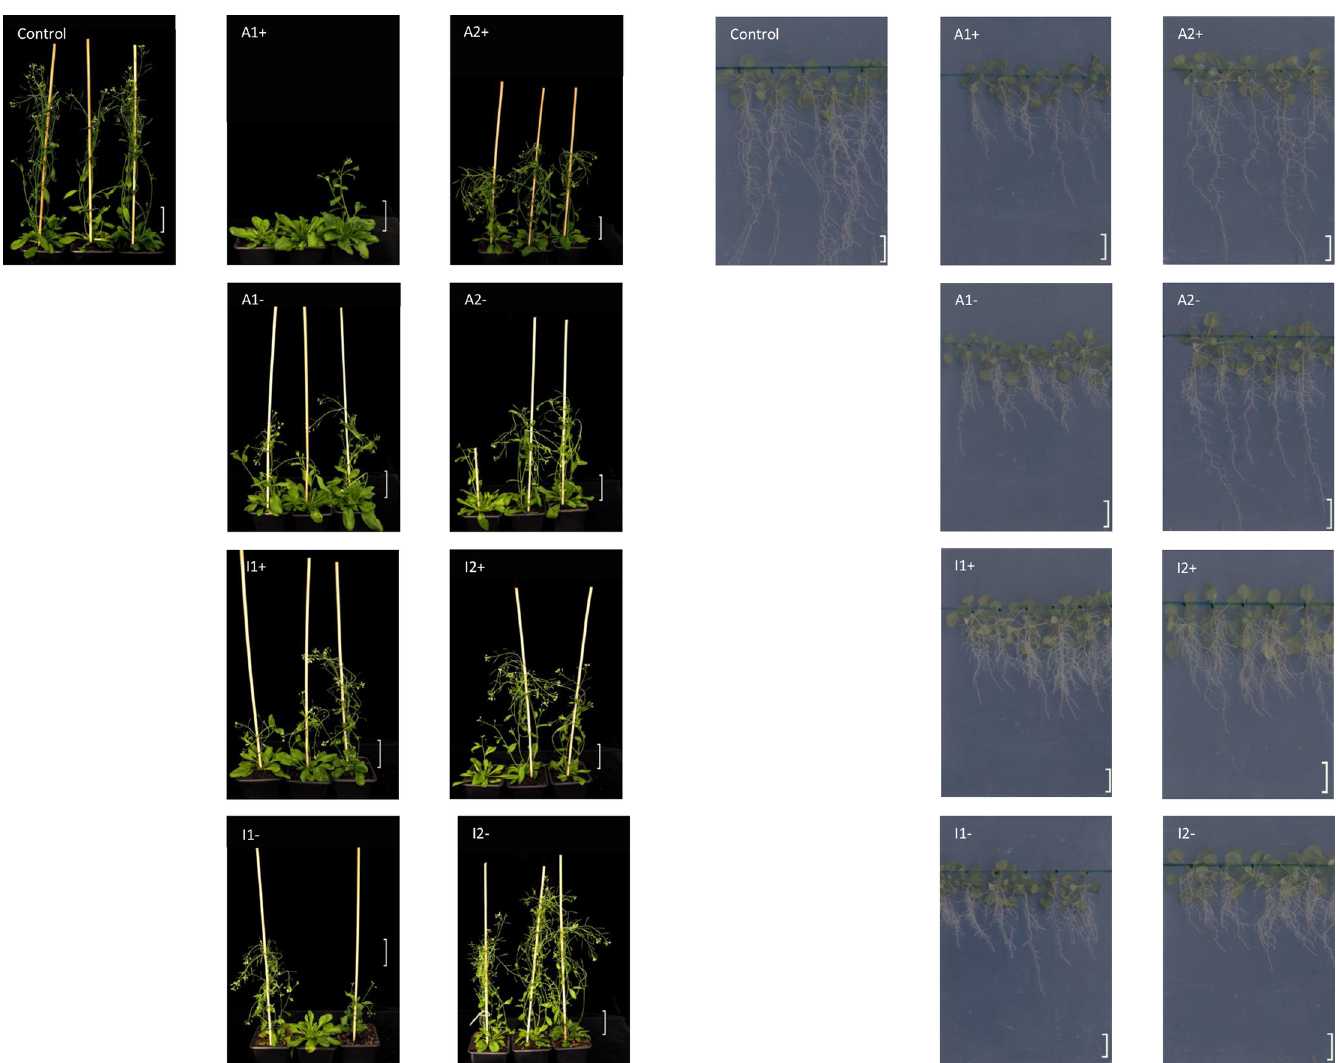
Fig 1. Shoot and root phenotypes in wildtype control plants, in MET1 transformants (+) and in lines derived from MET1 transformants, from which the transgene has been removed (-). Lines A1 and A2 express a catalytically active MET1 transgene, lines I1 and I2 express a catalytically inactive MET transgene. Images were taken eight weeks after stratification. The scale bar for shoot images indicates 5cm, the scale bar for root images indicates 10mm.